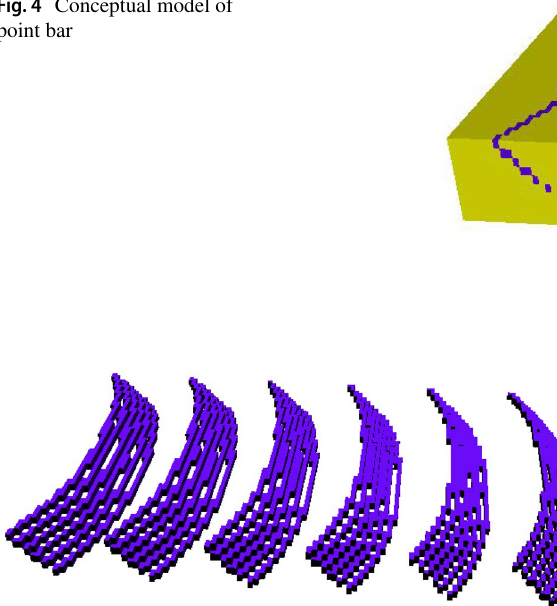
Fig. 6 Flow field strength dis- tribution at the reservoir bottom without considering parameters as time-varying